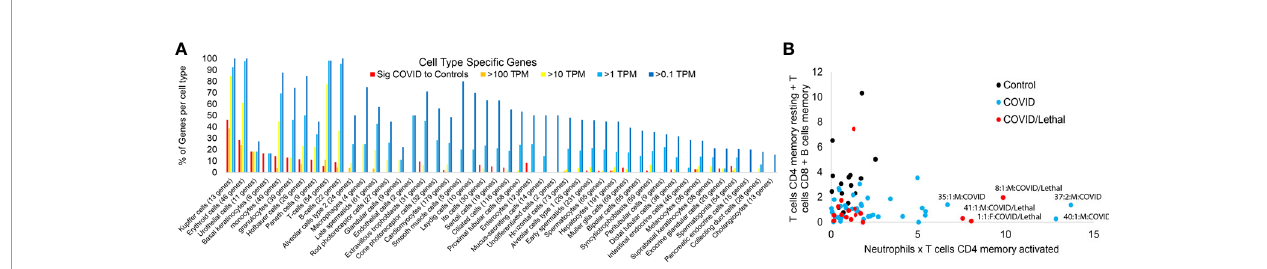
FIGURE 5 | Blood transcriptome cell-speci fi c gene signatures of SARS-CoV-2 patients. (A) The number of genes unique to various cell types (x-axis) expressed in the signi fi cant group of Figure 1 (red) or have expression in one or more of the samples greater than 100 TPM (orange), >10 TPM (yellow), or >1 TPM (cyan). (B) Absolute values of CIBERSORTx additive for resting CD4 T-cells, CD8 T-cells, and memory B-cells relative to neutrophil and CD4 memory T-cells within the control (black), COVID-19 (cyan), or COVID-19 lethal